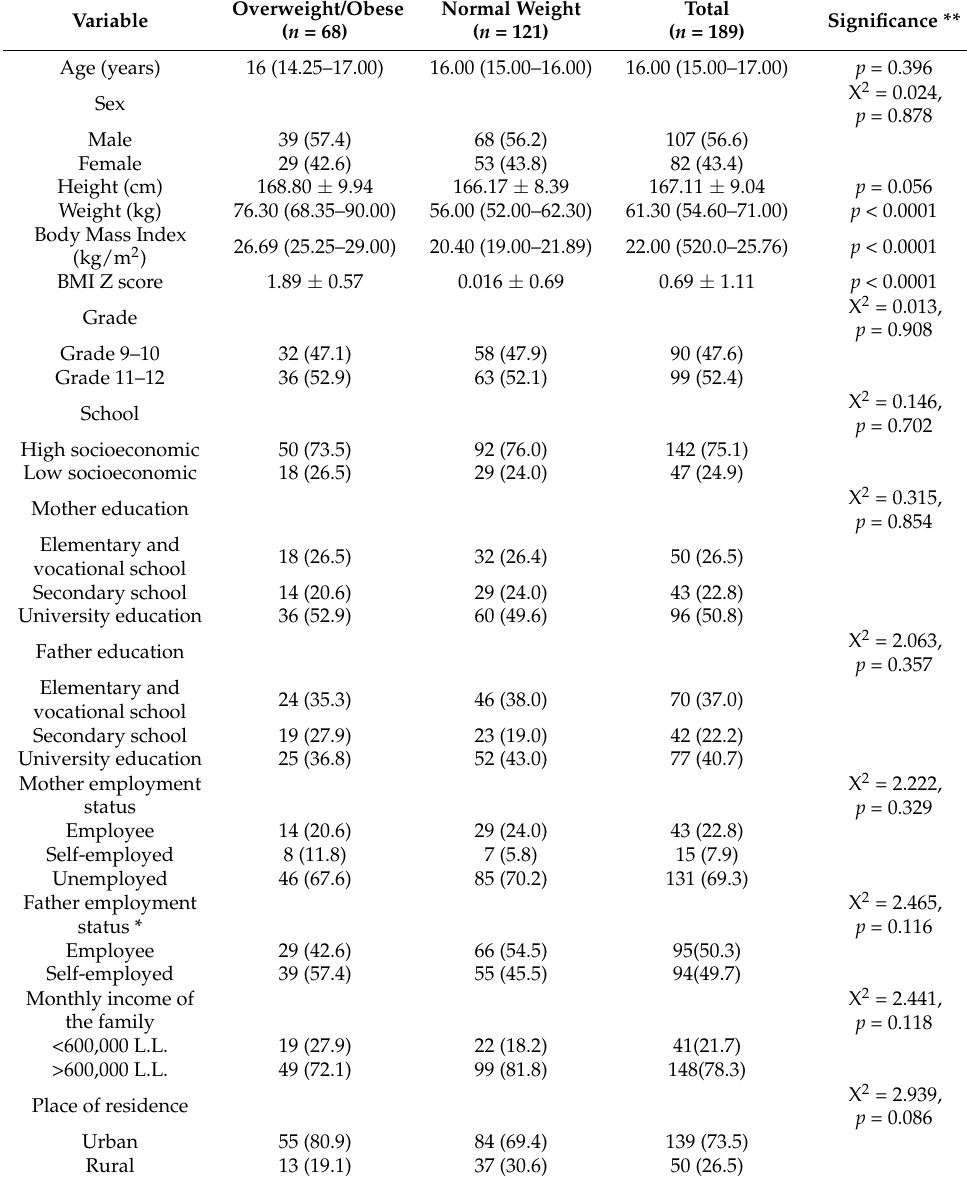
Table 1. Sociodemographic and anthropometric characteristics of the study population ( n = 189) }